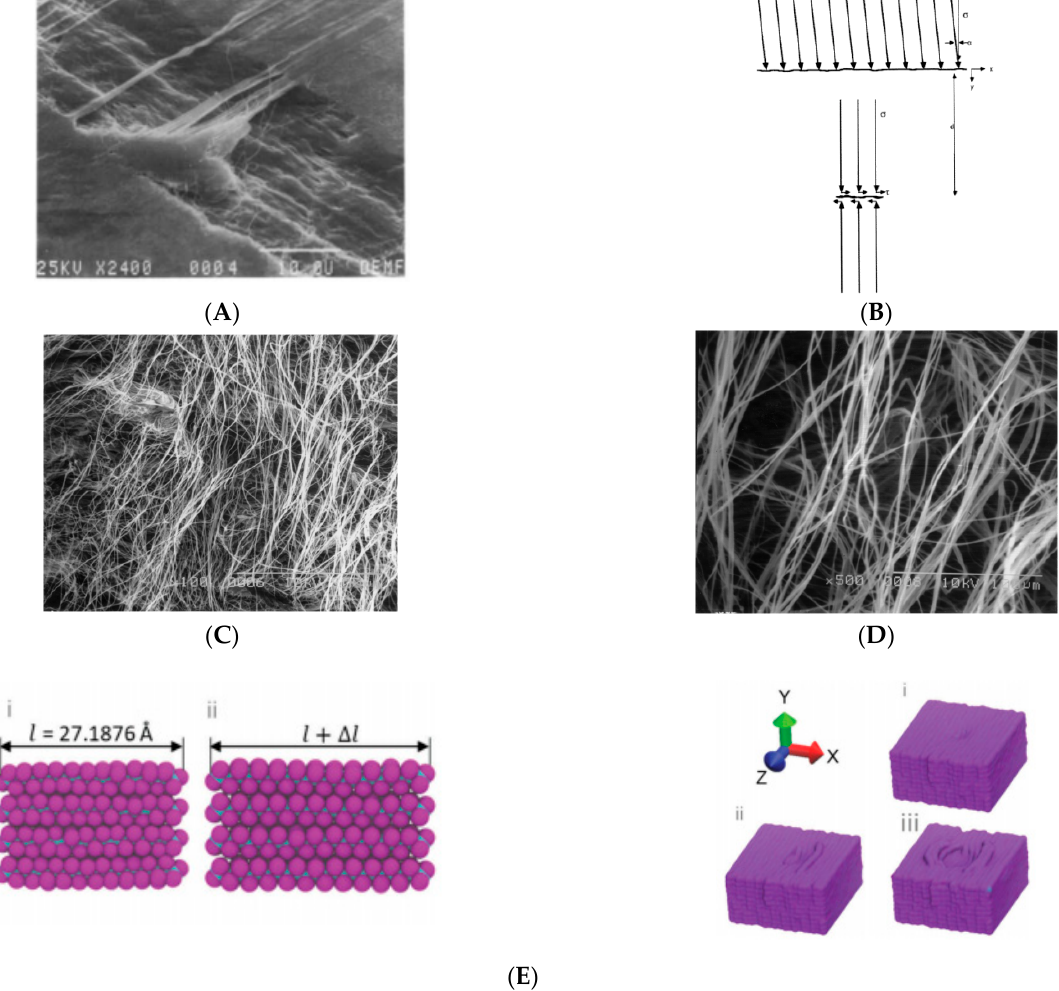
Figure 1. ( A ) Electron image of strip formation and ( B ) schematic drawing of crack [6], and micro- graph of damage species on the fracture surface within the stage of stable crack propagation for the virgin polytetrafluoroethylene (PTFE) ( C ) 100 × , ( D ) 500 × [7], Deformation and indentation of PTFE [8] ( E